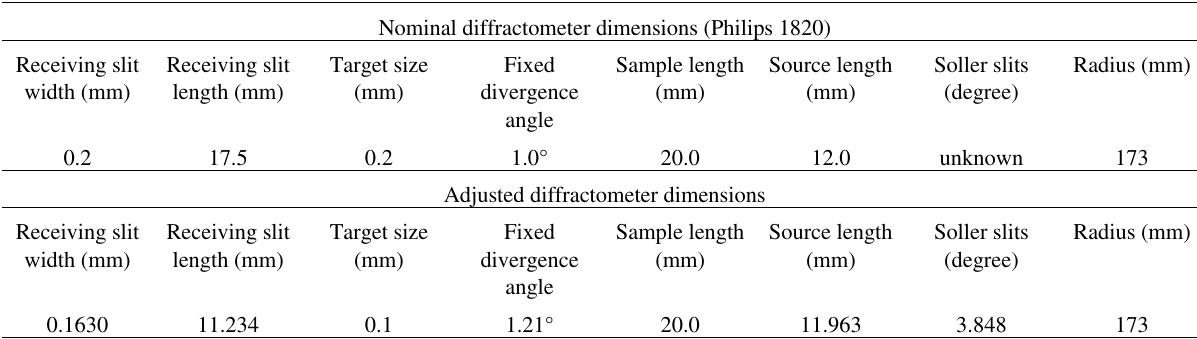
Figure 1. Experimental and instrument X-ray diffraction profiles at (0 8 0) for sample with nominal 200 Å crystallite Table 1. Comparison of the nominal diffractometer dimensions and adjusted dimensions determined by fitting the NIST standard material, LaB 6 .